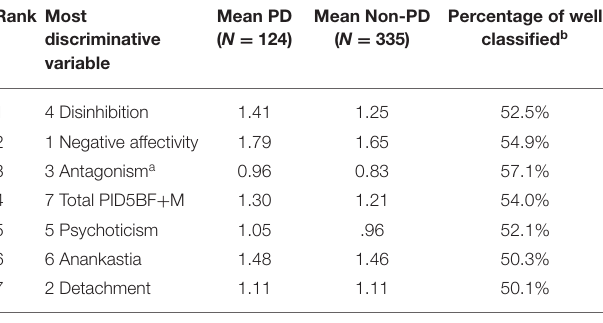
TABLE 2 | Discriminant factor analysis for the PID5BF in the personality disorder (PD) and non-personality disorder (non-PD) samples. Rank Most discriminative